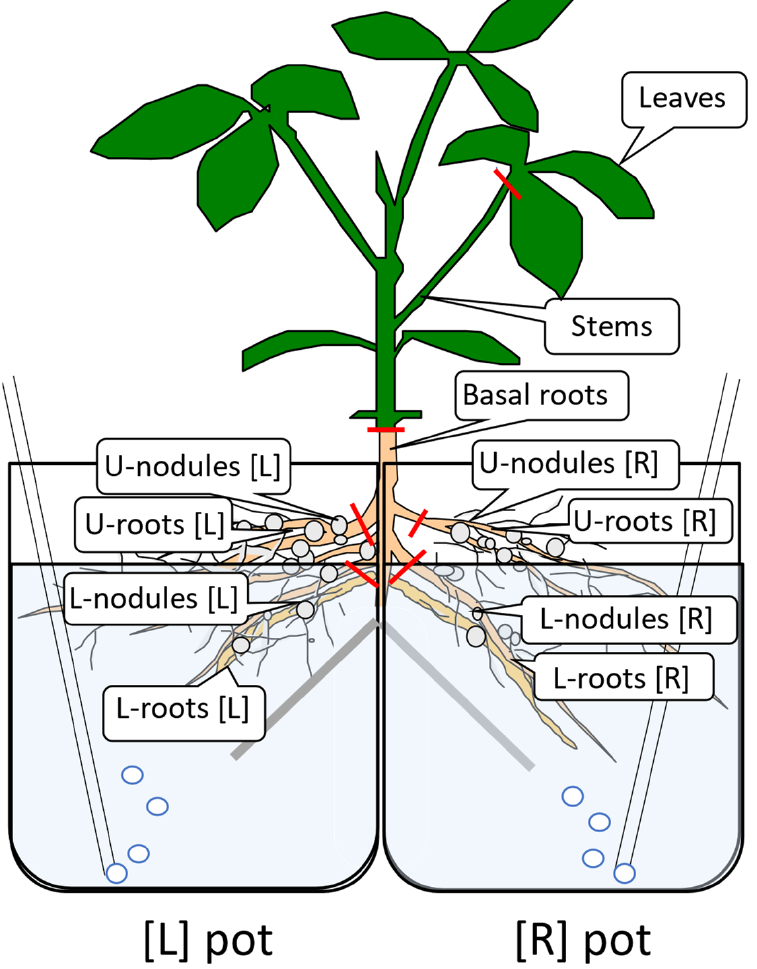
Figure 1. Split-root experimental setting. Three treatments were imposed, N0-N0, 15 N-N0, and 15 N-N5. In N0-N0 treatment, both pots contained N-free solution. In 15 N-N0, and 15 N-N5 treatments, the culture solution with 15 N-labeled 5 mM NO 3 − was supplied from the pot on the left [L], and either N-free ( 15 N-N0) or non-labeled 5 mM NO 3 − ( 15 N-N5) was supplied in the pot in the right [R]. Both pots were continuously aerated. Plants were harvested at 2 days (2 DAT) and 4 days (4 DAT) of treatments. Plant parts separated at the red line.